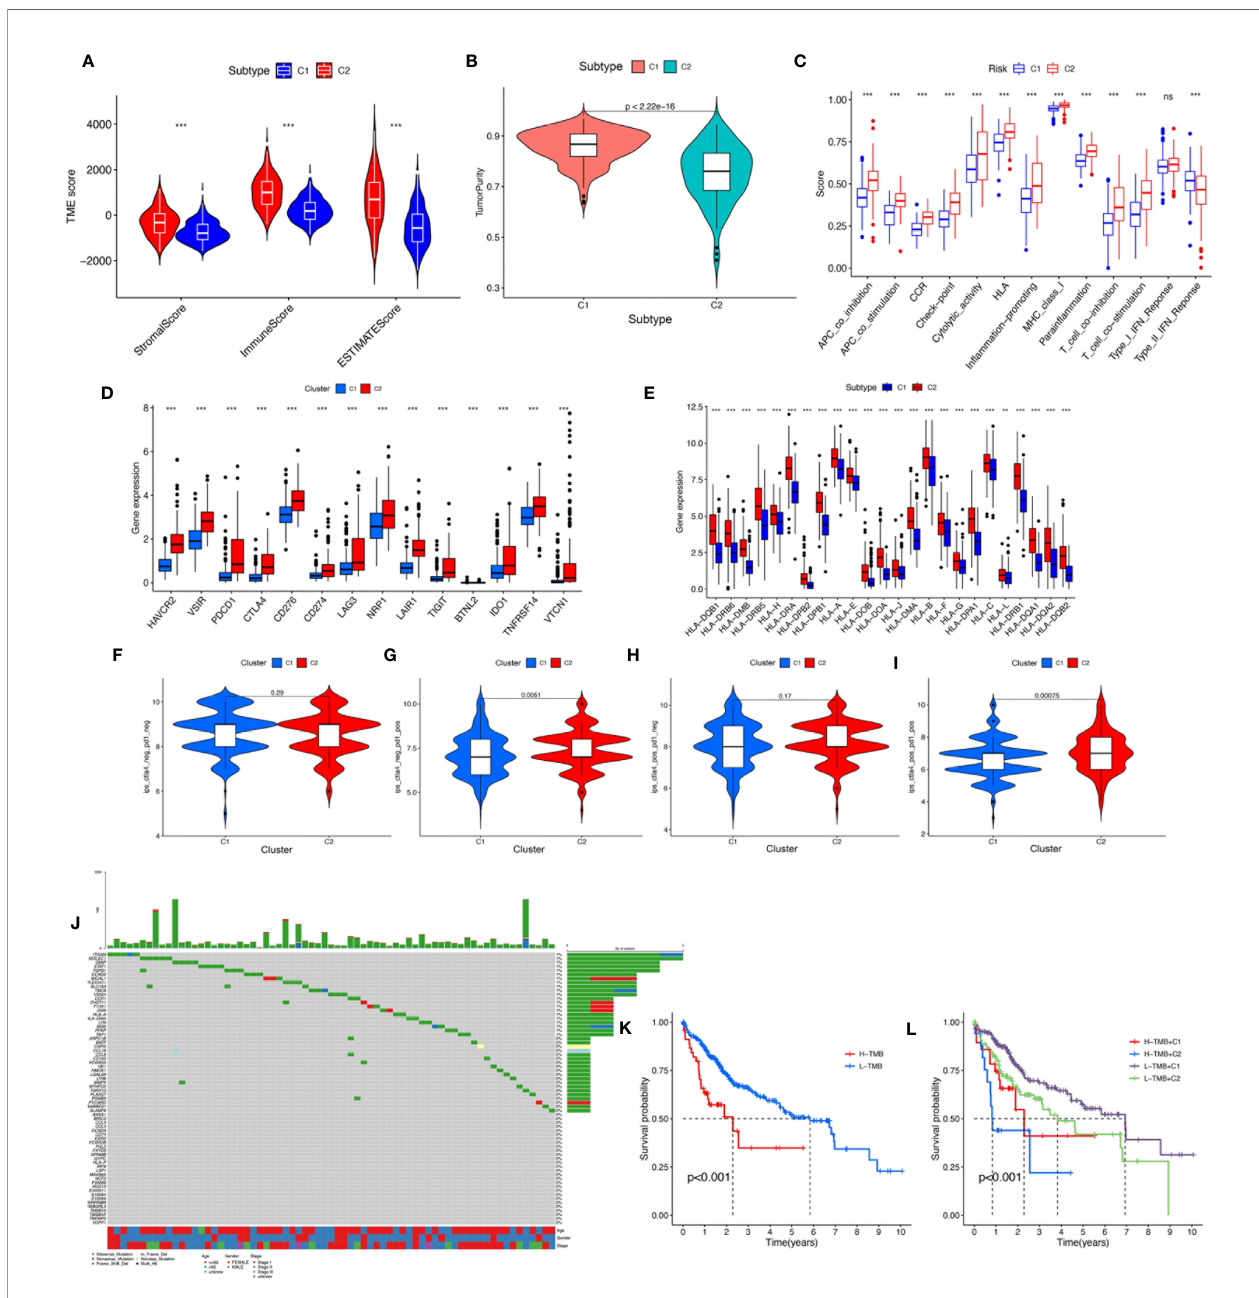
FIGURE 4 | (A) The comparisons of stromal score, immune score, and estimate score between different clusters. (B) The comparisons of tumor purity between different clusters. (C) The boxplot illustrating the difference in immune-related functions between different clusters. (D) The boxplot displaying the difference in immune checkpoint genes between different clusters. (E) The boxplot displaying the difference in HLA expression between different cluster groups. (F) CTLA4 − _PD1 − , (G) CTLA4 − _PD1 + , (H) CTLA4 + _PD1 − , and (I) CTLA4 + _PD1 + . The comparison of immunophenoscore (IPS) between different cluster groups. (J) Somatic mutation landscape of macrophage- related differentially expressed genes was presented by a waterfall map. (K) The Kaplan – Meier curve survival analysis between the high- and low-TMB groups. (L) The Kaplan – Meier curve survival analysis for HCC patients strati fi ed by both TMB groups and clusters. ns, not signi fi cant; ** P < 0.01; *** P <